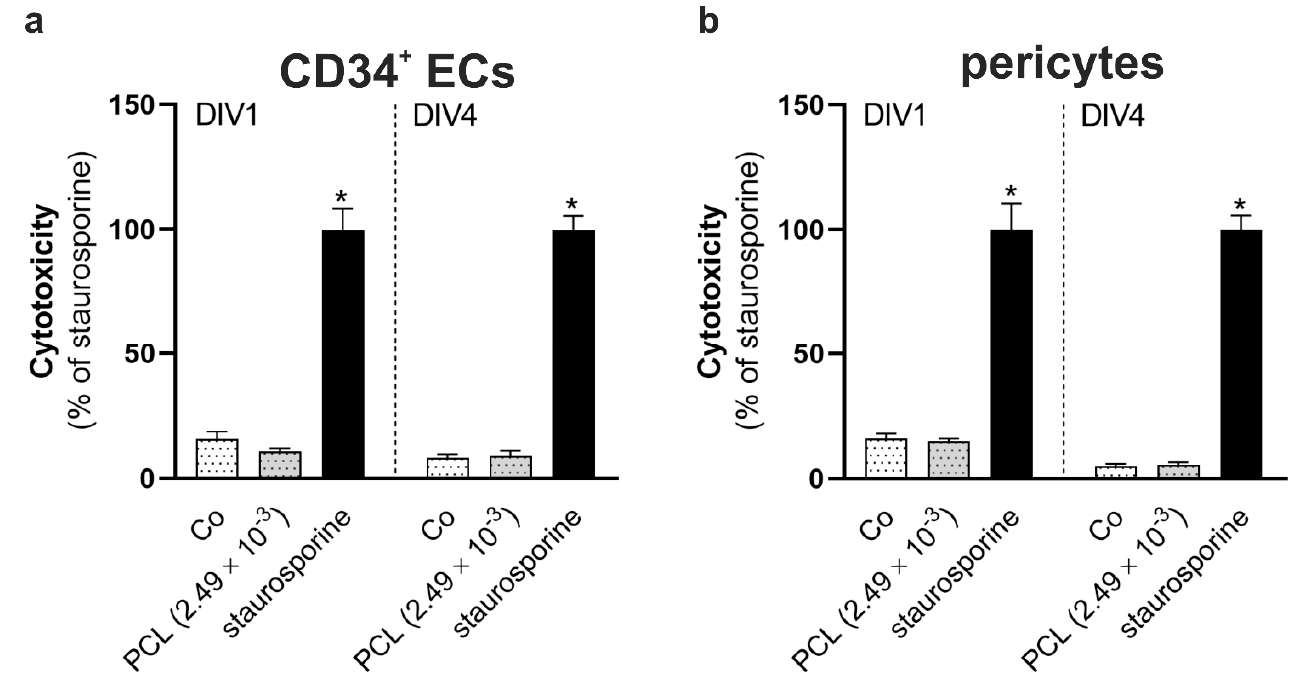
Figure 2. Cytotoxicity of PCL-NPs after exposure for 24 h on day in vitro (= DIV) 1. CD34+ ECs ( a ) and pericytes ( b ) were exposed to PCL-NPs at a concentration of 2.49 × 10 − 3 µ g/mL for 24 h on DIV1 (dotted bars) ( n = 3). Stimulation with staurosporine in dimethyl sulfoxide (DMSO) (final concentration: 2 µ M) for 24 h was used as positive control (black bars) and carried out on DIV1 or on DIV4 before detecting cytotoxicity. Non-exposed or –stimulated cells were used as control (Co). Error bars represent SEM. Significant differences compared to the positive control are labeled with asterisks (*) (* = p ≤ 0.0001).